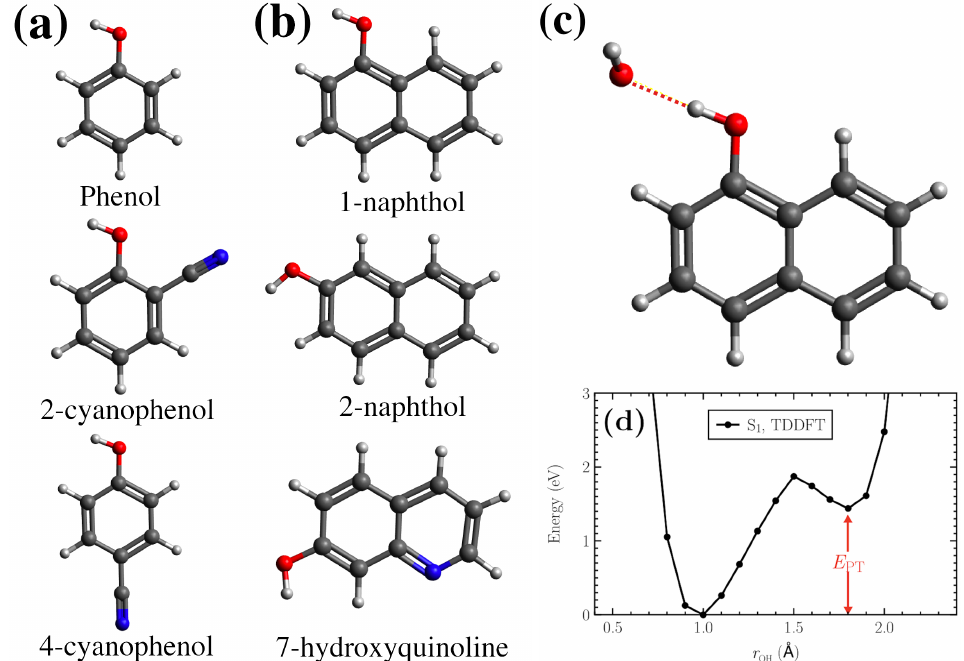
Figure 1. ( a , b ) The prototypical photoacids considered in this work. ( c ) 1-Naphthol/water complex. Similar complexes are used for each photoacid in order to calculate the respective proton dissociation curves. ( d ) Reference proton dissociation curve for the 1-naphthol/water complex in ( c ) obtained using TDDFT calculations at S 1